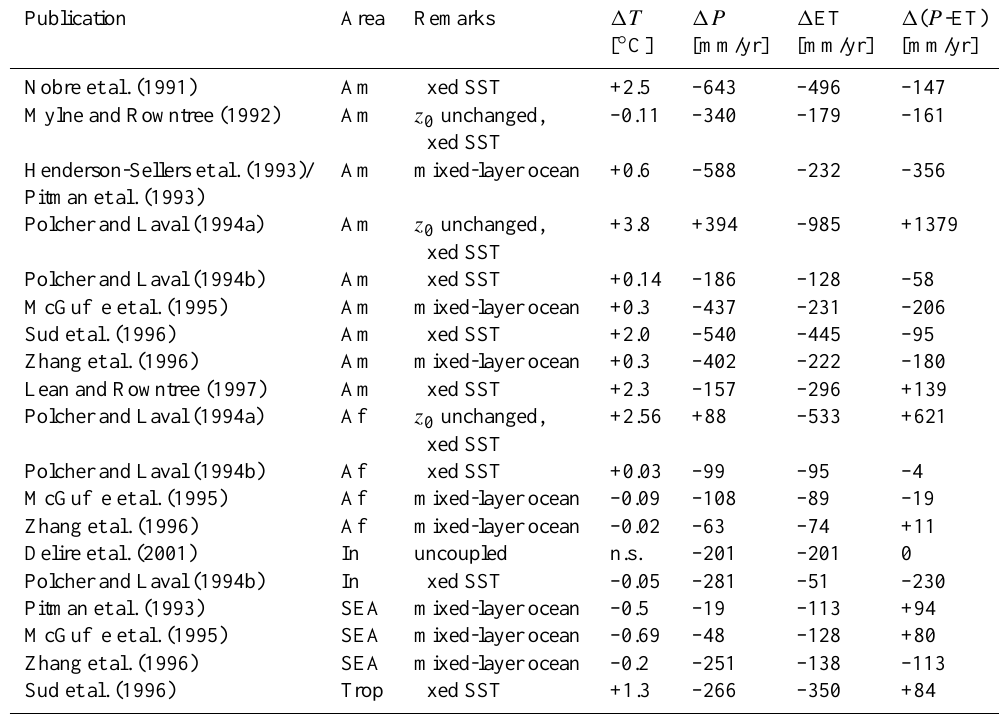
Table 5. Changes in surface temperature ( T ), precipitation ( P ), evapotranspiration (ET) and moisture convergence ( P -ET) in Amazonia (Am), tropical Africa (Af), Indonesia (In), South-Eastern Asia (SEA) and the whole tropics (Trop) in previous (biogeophysical) model studies of large-scale deforestation. Zhang et al. (1996) refer to surface air temperature instead of ground surface temperature. In Pitman et al. (1993) this information is not